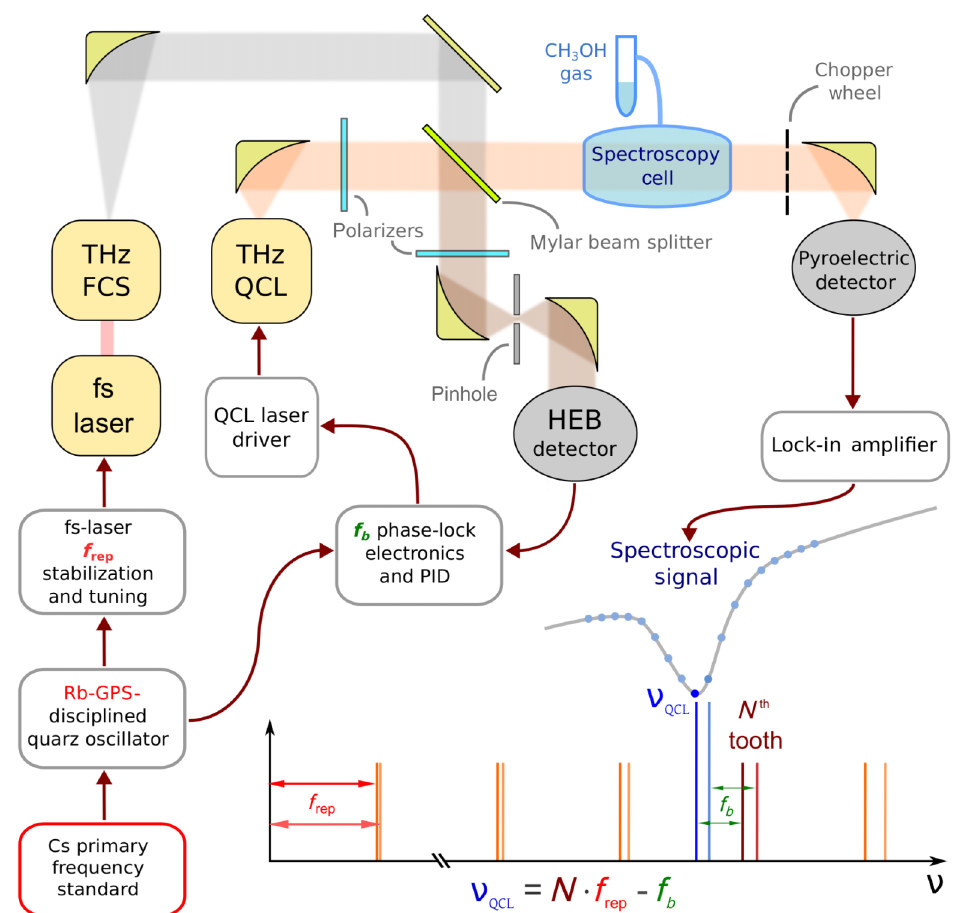
FIG. 1. The scheme of the experimental setup is shown, with the diagram describing how the traceability of the primary Cs frequency standard is transferred to the THz QCL-based spectroscopy via the stabilization of the repetition rate ( f ) of the pump laser and the THz rep FCS. The mechanism for tuning the QCL frequency ( ν ) is also sketched: The beat-note frequency ( f ) is kept constant by the phase- b QCL lock loop, while the tuning of f produces a proportional shift of the THz comb tooth, and thus of the QCL absolute frequency. The rep lock-in acquisition of the absorption signal requires the beam intensity to be mechanically modulated by a chopper. HEB – hot-electron bolometer; PID – proportional-intergal-derivative